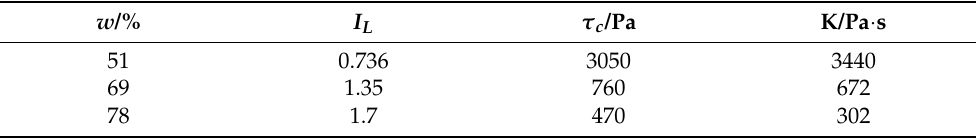
Table 2. Rheological parameters of soil